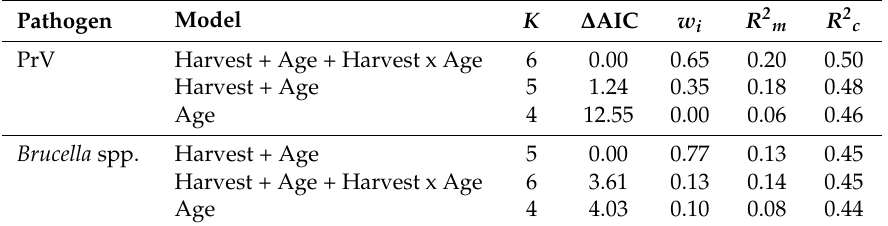
Table 3. Top three models for the response of pseudorabies virus (PrV) or Brucella spp. exposure to harvest method, wild pig age, and the interaction between harvest method and age.